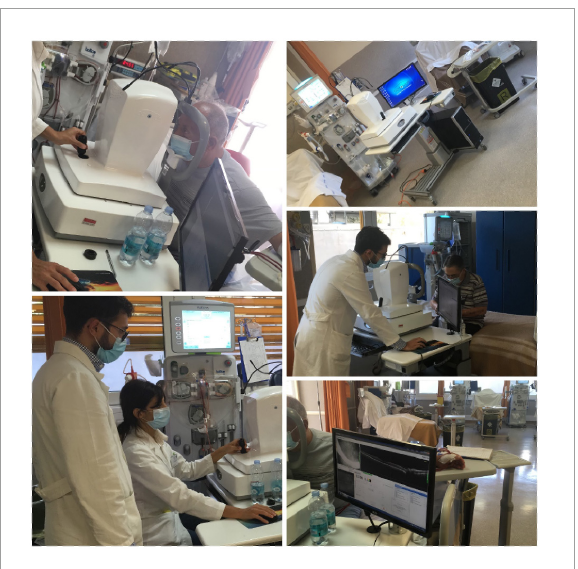
FIGURE1 Acquisition of OCT-A parameters during in a haemodialysis